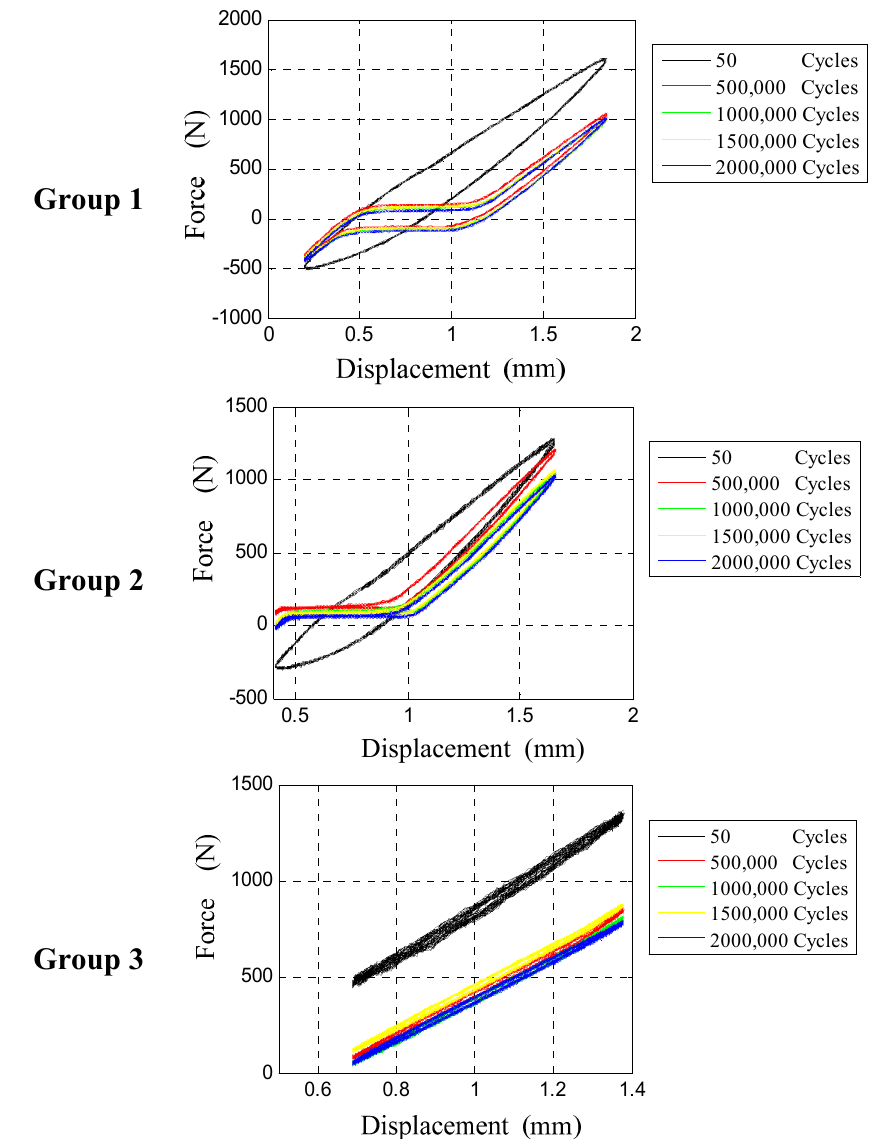
Figure 4. Three sets of fatigue test displacement hysteresis curves.